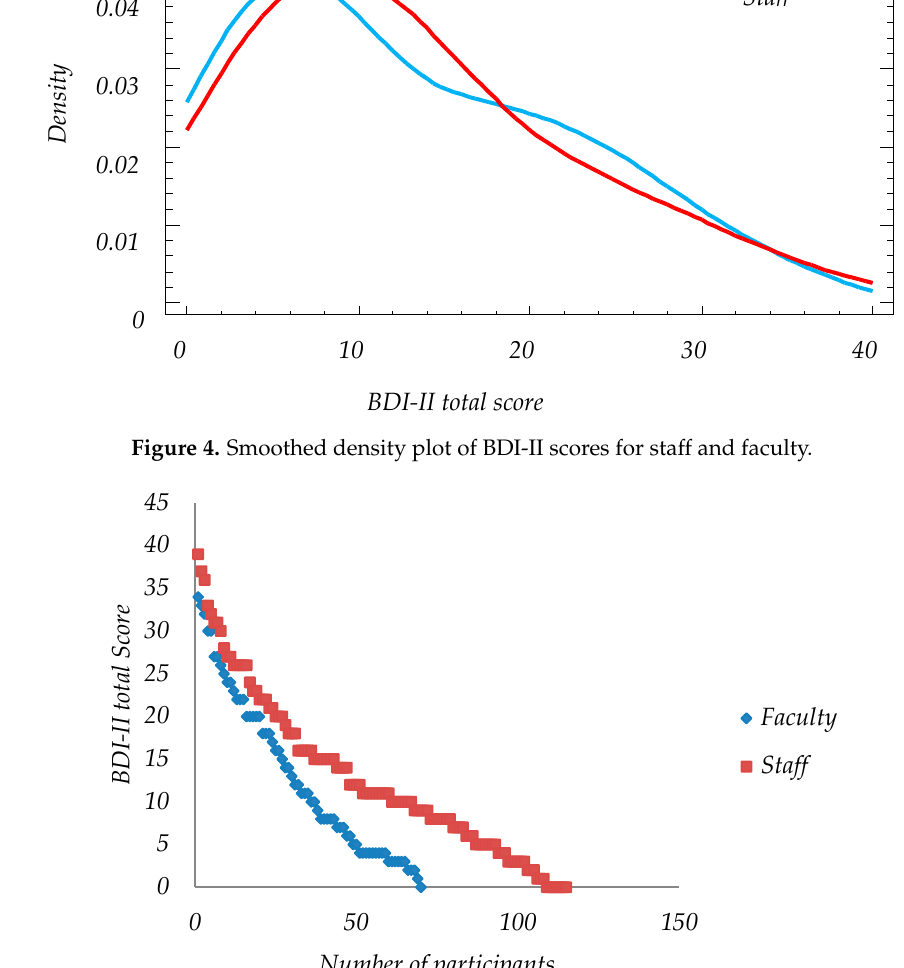
Figure 5. Dispersion plot of BDI-II scores for staff and faculty.